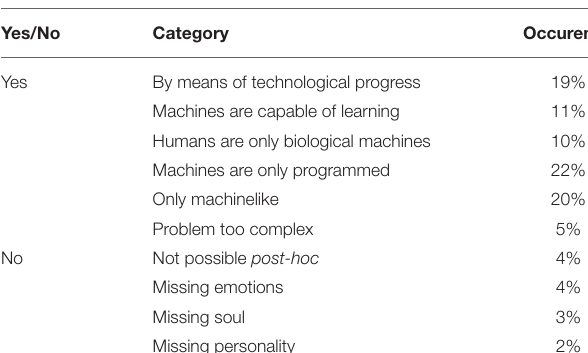
TABLE 3 | Reasons why robots can or cannot develop a self. Question: Please back up your opinion: Why/why not?